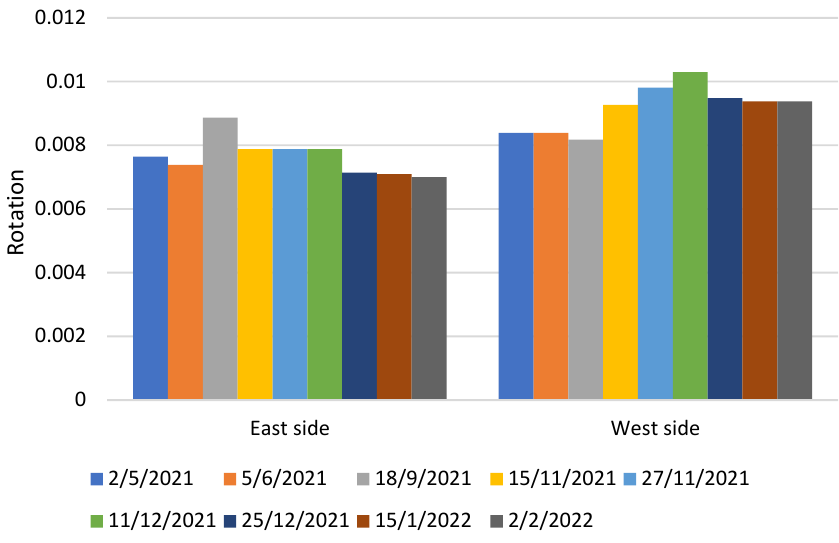
Figure 5. Rotation of east and west sides with respect to time.